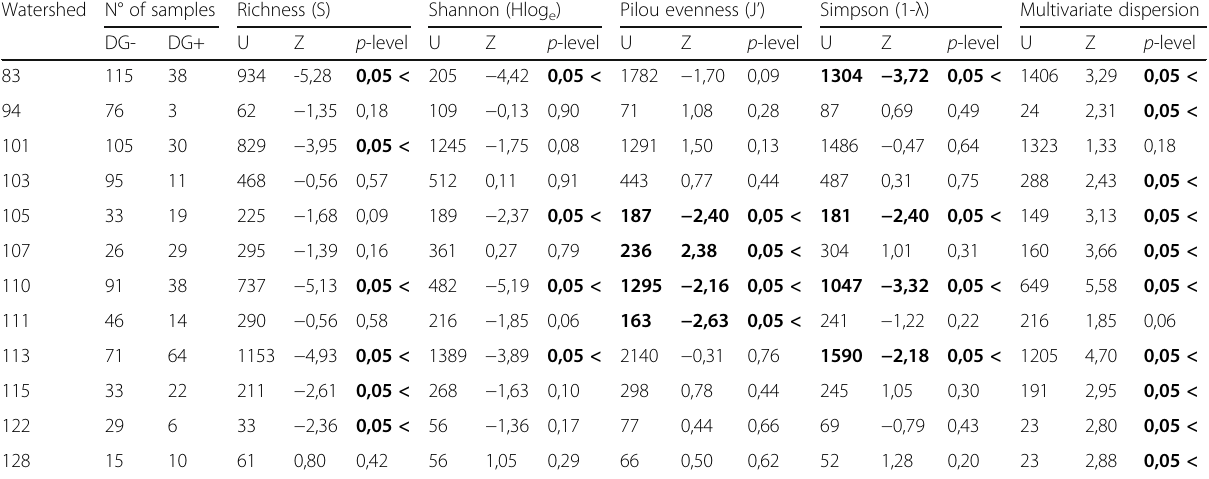
Table 1 Number of samples and diversity parameters estimated for the invaded (Dg+) and not invaded (Dg-) in each studied basin Watershed N° of samples Richness